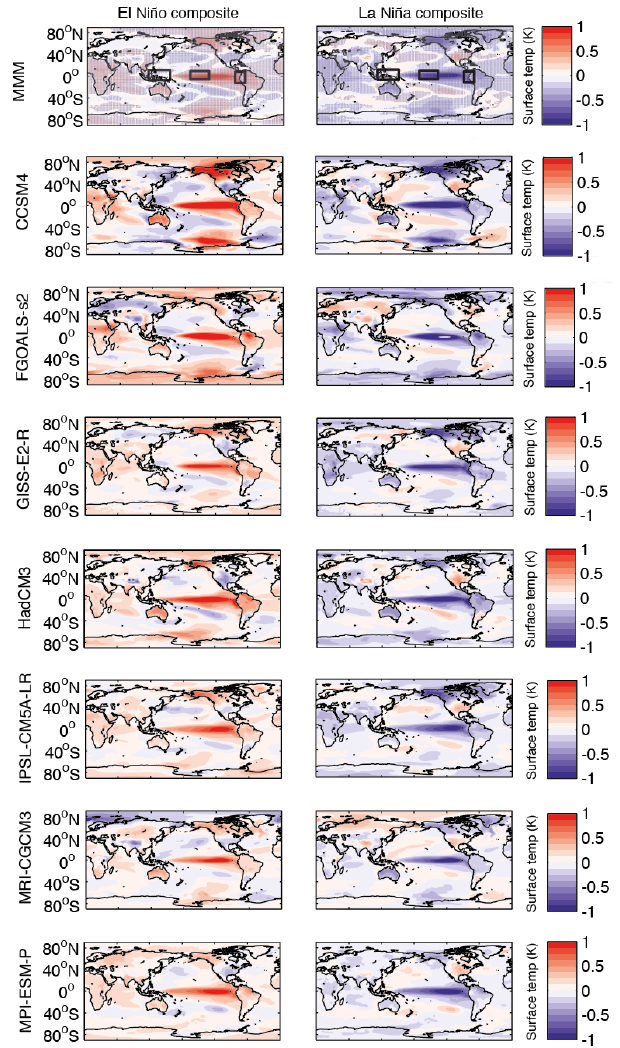
Figure 2. As for Fig. 1, but showing composites from Last Millen- nium